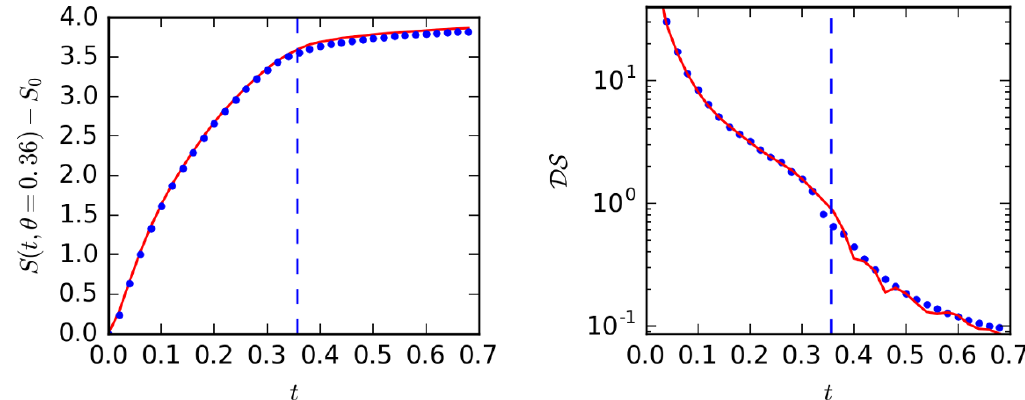
Figure 2 . Entanglement entropy (with t = 0 contribution subtracted, left) and its logarithmic time derivative (right) after a quench from (cid:22) = 10 to (cid:22) = 0 : 5, as a function of time. The polar cap has a radius of 0 : 36 rad. The blue points correspond to the results on the fuzzy sphere with N = 400 and the red line is an interpolation of the results on the commutative sphere with N = 199. N needs to be so high on the fuzzy sphere to accurately probe a small polar cap. The dashed vertical line indicates the expected saturation time, t = 0 : 36.